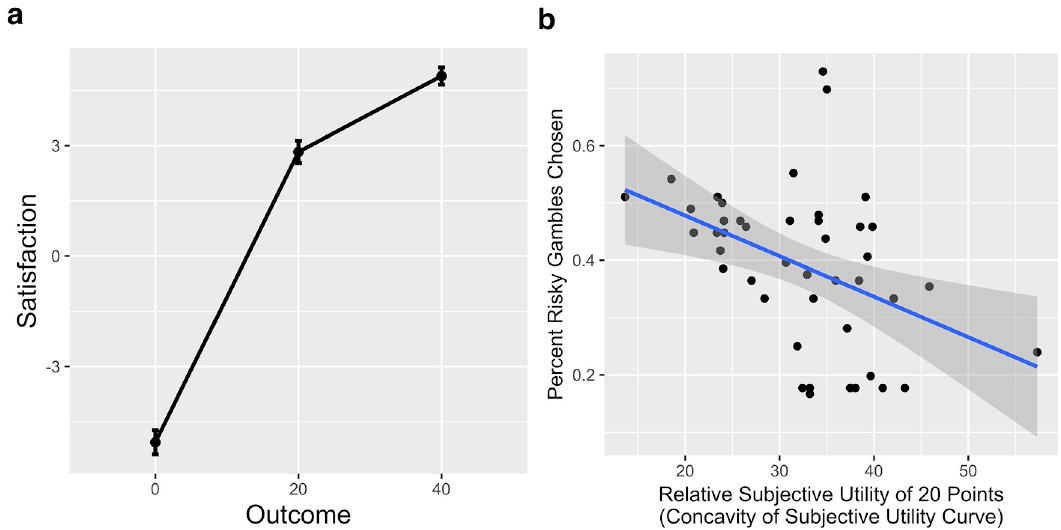
Fig 1. Subjective satisfaction and risk preferences. (a) Subjective utility curve constructed with mean satisfaction ratings for winning 0, 20, or 40 virtual dollars. The subjective utility curve was concave, i.e. the satisfaction with winning 20 points was greater than the mean satisfaction with winning 0 and 40 points, as predicted by economic theory. (b) Relationship between the shape of the subjective utility curve and risk preferences on the task. Subjects with a more concave subjective utility curve (i.e. a higher relative evaluation of 20 points), were more risk averse, as predicted by economic theory.